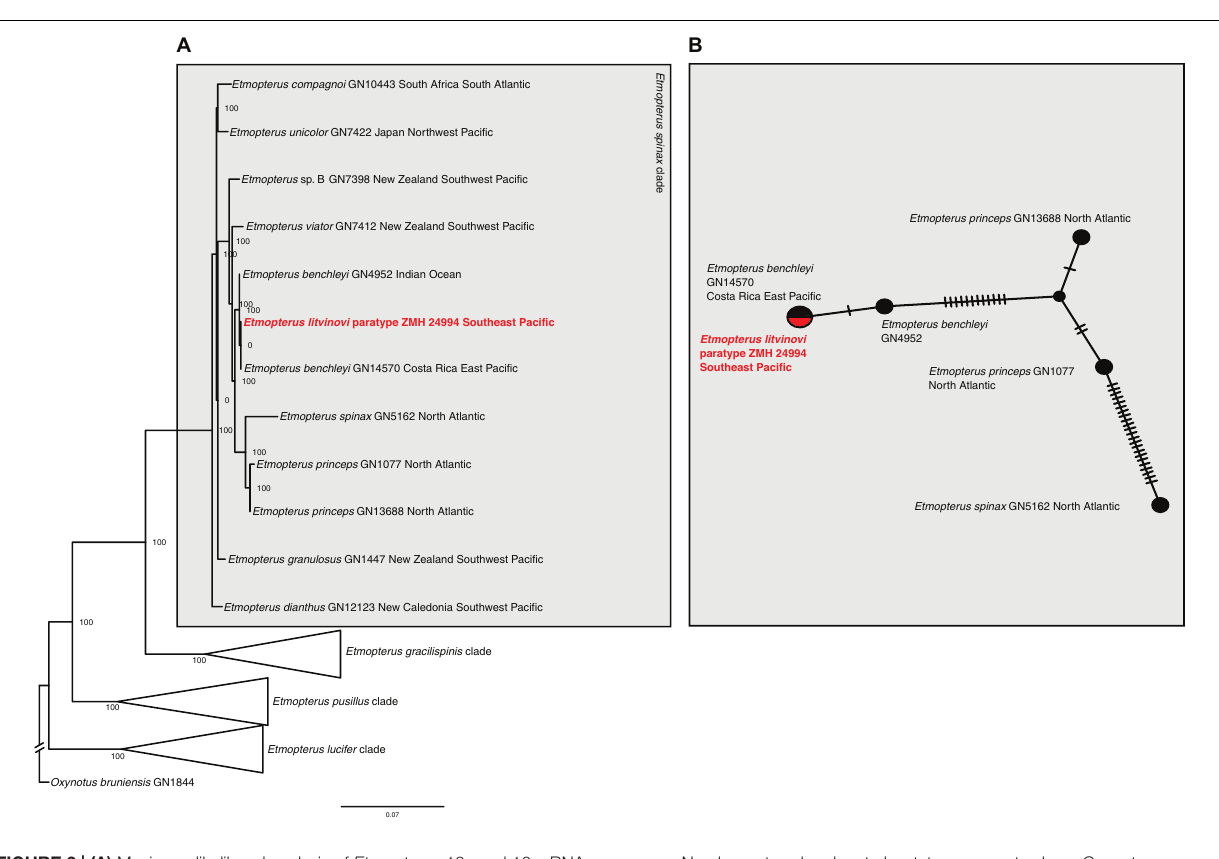
the E. spinax clade is on average 1.6% ( Supplementary Table 3A ),